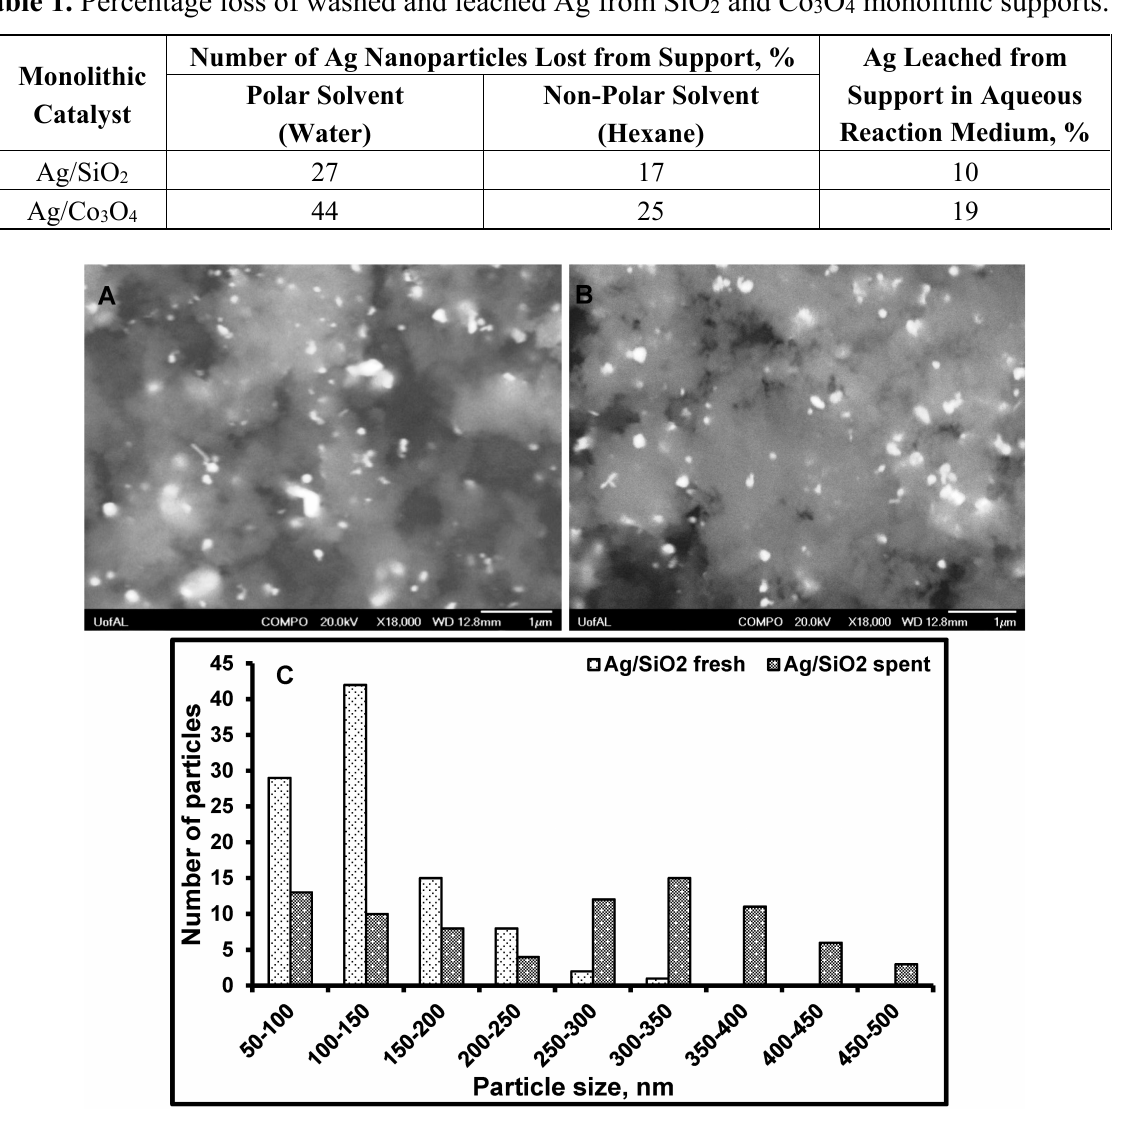
Figure 11. Washing studies of Ag/SiO 2 in hexane: ( A ) SEM of fresh Ag/SiO 2 ; ( B ) SEM of spent Ag/SiO 2 ; ( C ) particle size distribution of fresh and spent Ag/SiO 2